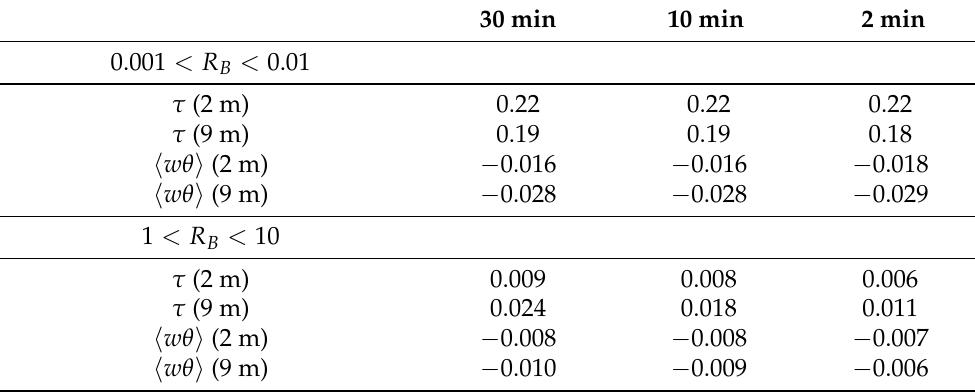
Table 2. As in Table 1, but for the vertical fluxes of momentum τ (in m 2 s − 2 ) and of heat (cid:104) w θ (cid:105) (in K m s − 1